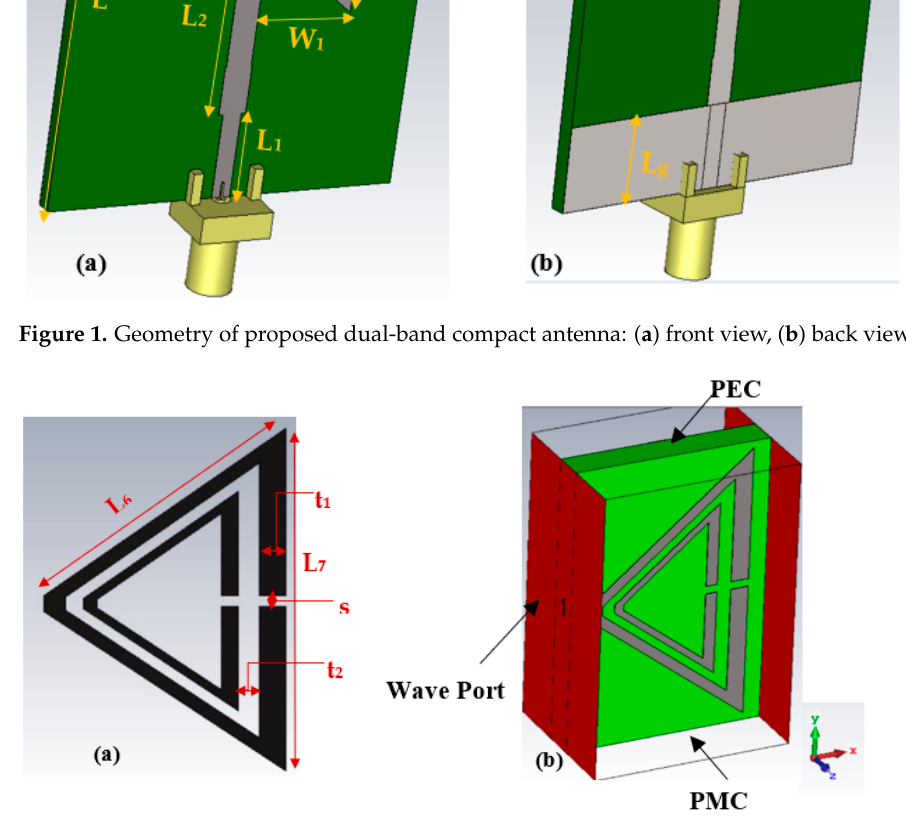
Figure 2. Layout of the triangular split-ring resonator: ( a ) unit-cell dimension, ( b ) CST simulation model. Table 1. The final dimensions of the proposed model.